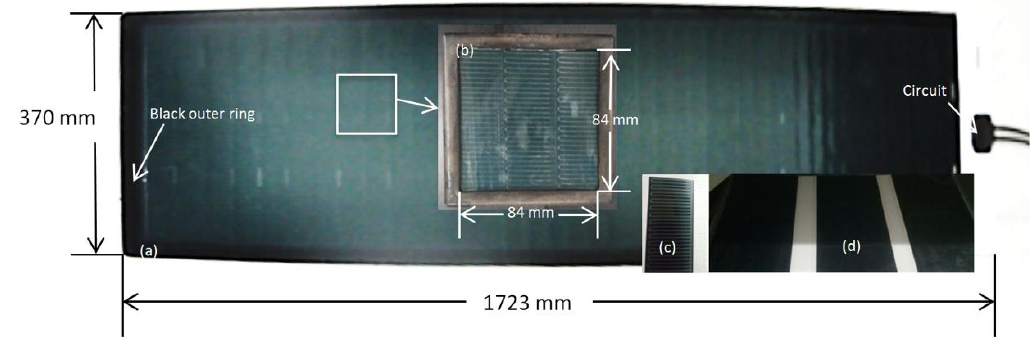
Figure 1. Copper, indium, gallium and selenium (CIGS) thin-film solar module and sample. ( a ) module; ( b ) specimen; ( c ) CIGS solar cell sample; ( d ) adhesive. ( b ) specimen; ( c ) CIGS solar cell sample; ( d )